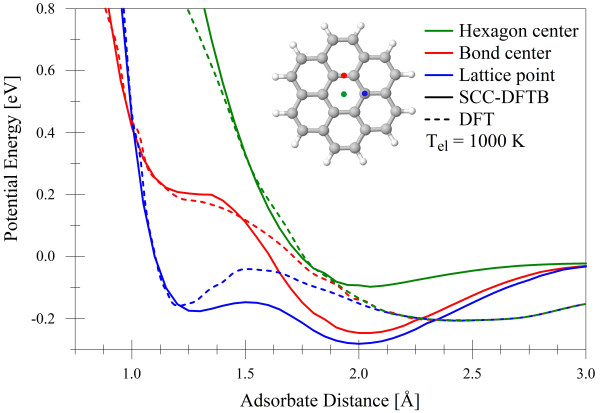
SCC-DFTB and LDA-DFT [25]potential energies of the hydrogen-coronene interaction.